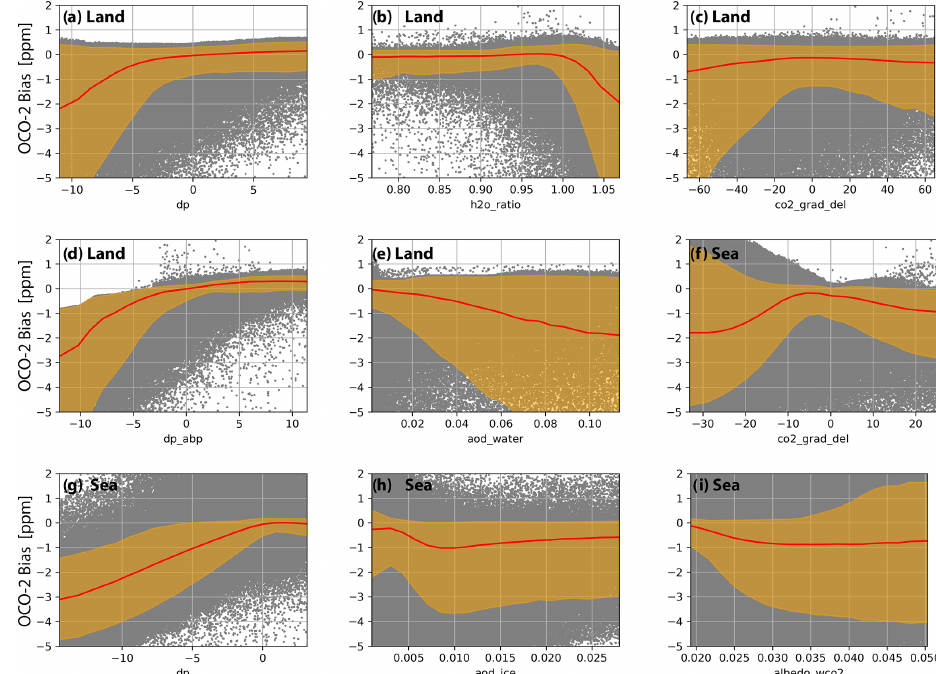
Figure 7. Bias identified by correction by the proposed model (OCO-2 bias) with respect to its features: dp (a) , h2o_ratio (b) , co2_grad_del (c) , dp_abp (d) , aod_water (e) over land and co2_grad_del (f) , dp (g) , aod_ice (h) , and albedo_wco2 (i) over sea for QF = 0 and QF = 1 data from 2018 to 2019. The 5th and 95th percentiles are indicated by the yellow shaded area, the mean is shown with a red line, and individual comparisons are shown with gray dots. The scale of the x axis is different for each plot. Please refer to Sect. 3.4 for a description of the individual features.